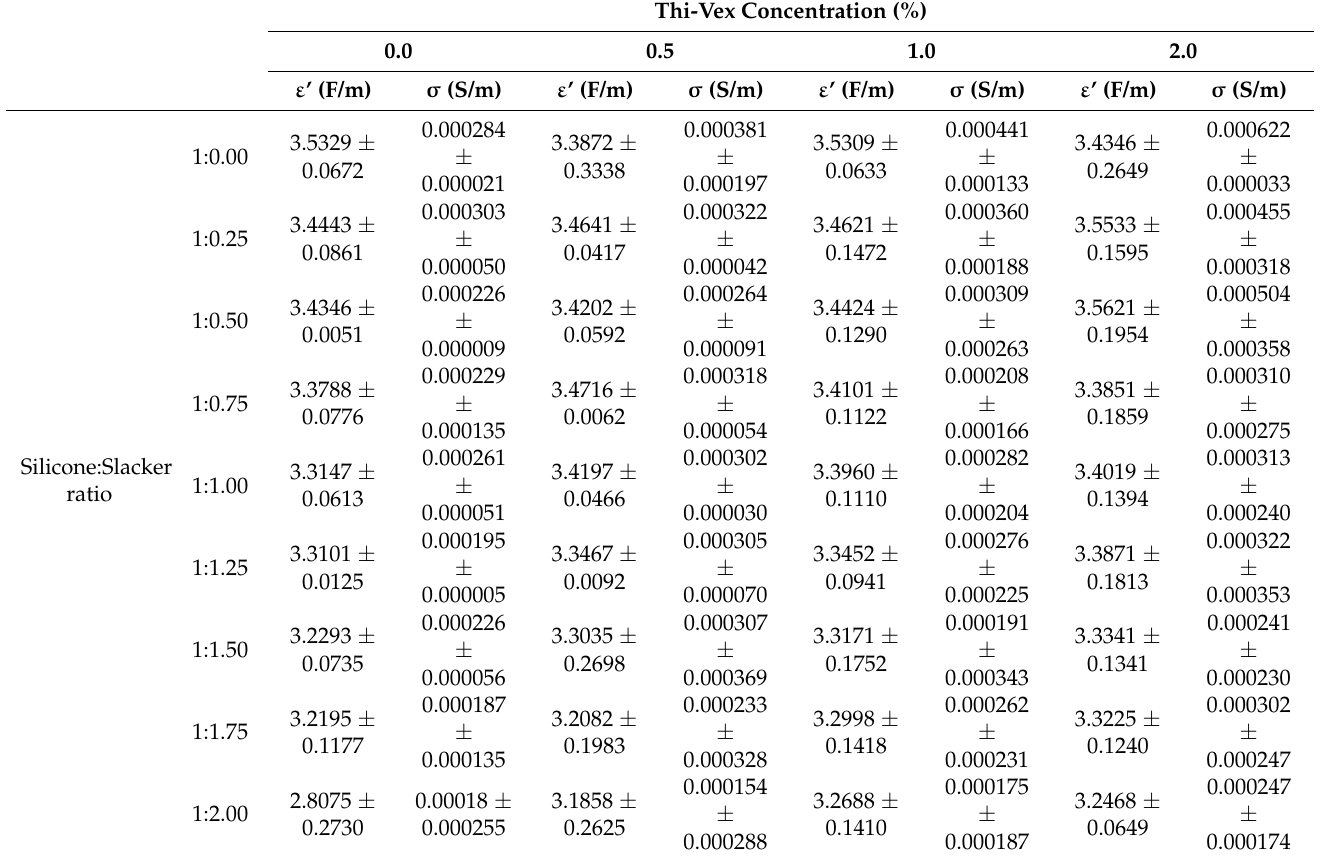
Table 1. Dielectric properties of the platinum-cured silicone relative to the concentrations of Slacker and